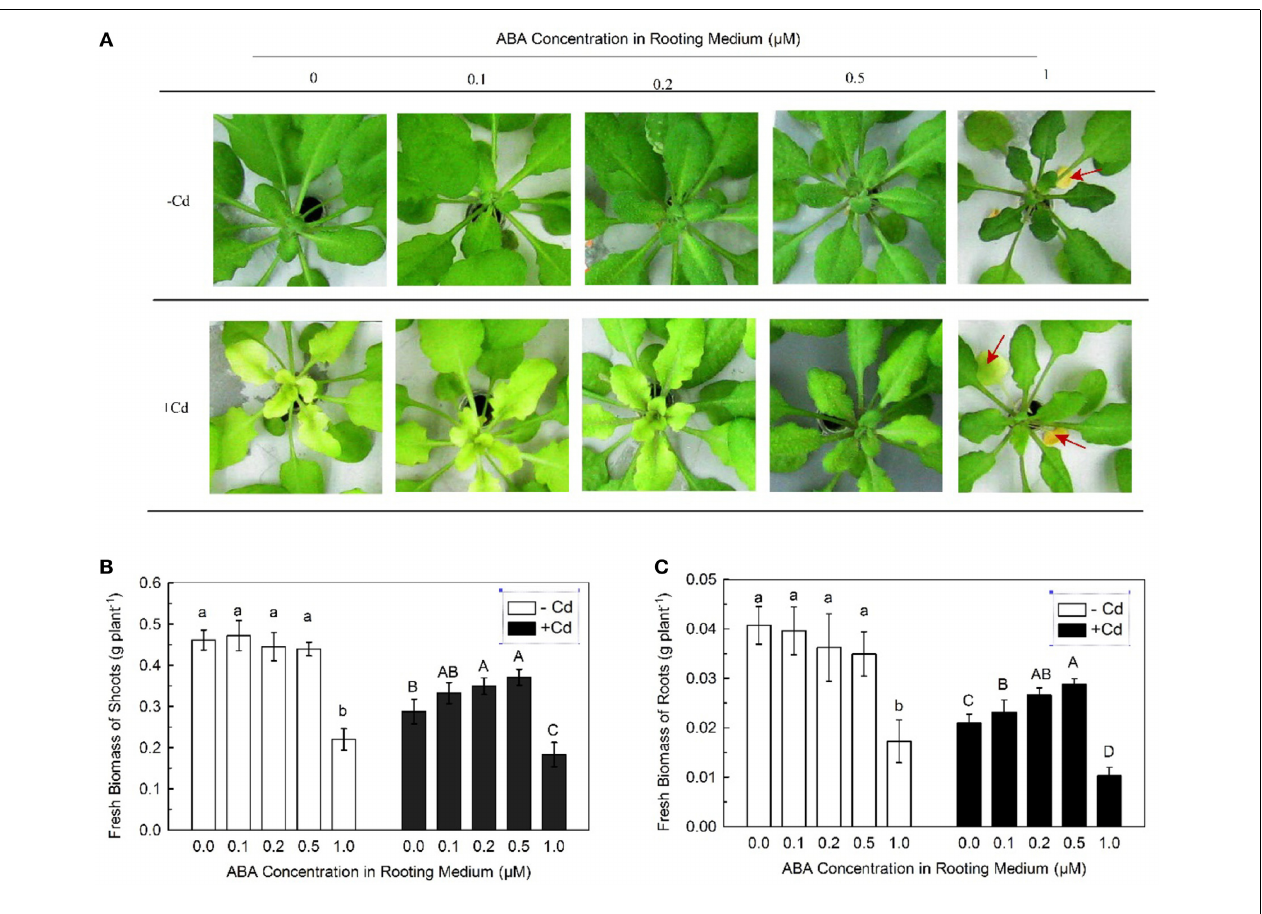
FIGURE 1 | Effects of varying doses of ABA on Cd tolerance of Col-0 plants. Plants were grown in Cd-free ( − Cd) or 10 µ M Cd-added ( + Cd) nutrient solution with varying concentrations of ABA added for 7 day. The Fe level in